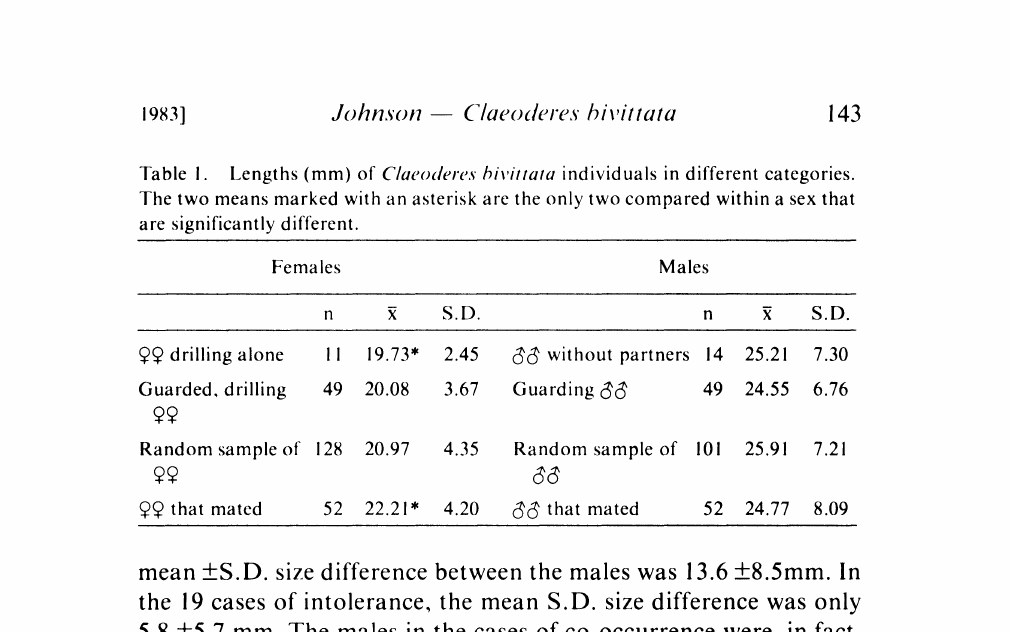
Table I. Lengths (mm) of Claeoderes hivittata individuals in different categories. The two means marked with an asterisk are the only two compared within a sex that are significantly